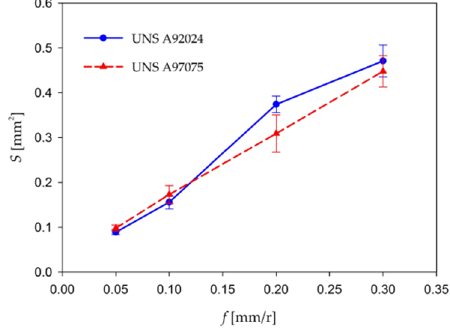
Figure 10. Chip cross-section area ( S ) as a function of feed.